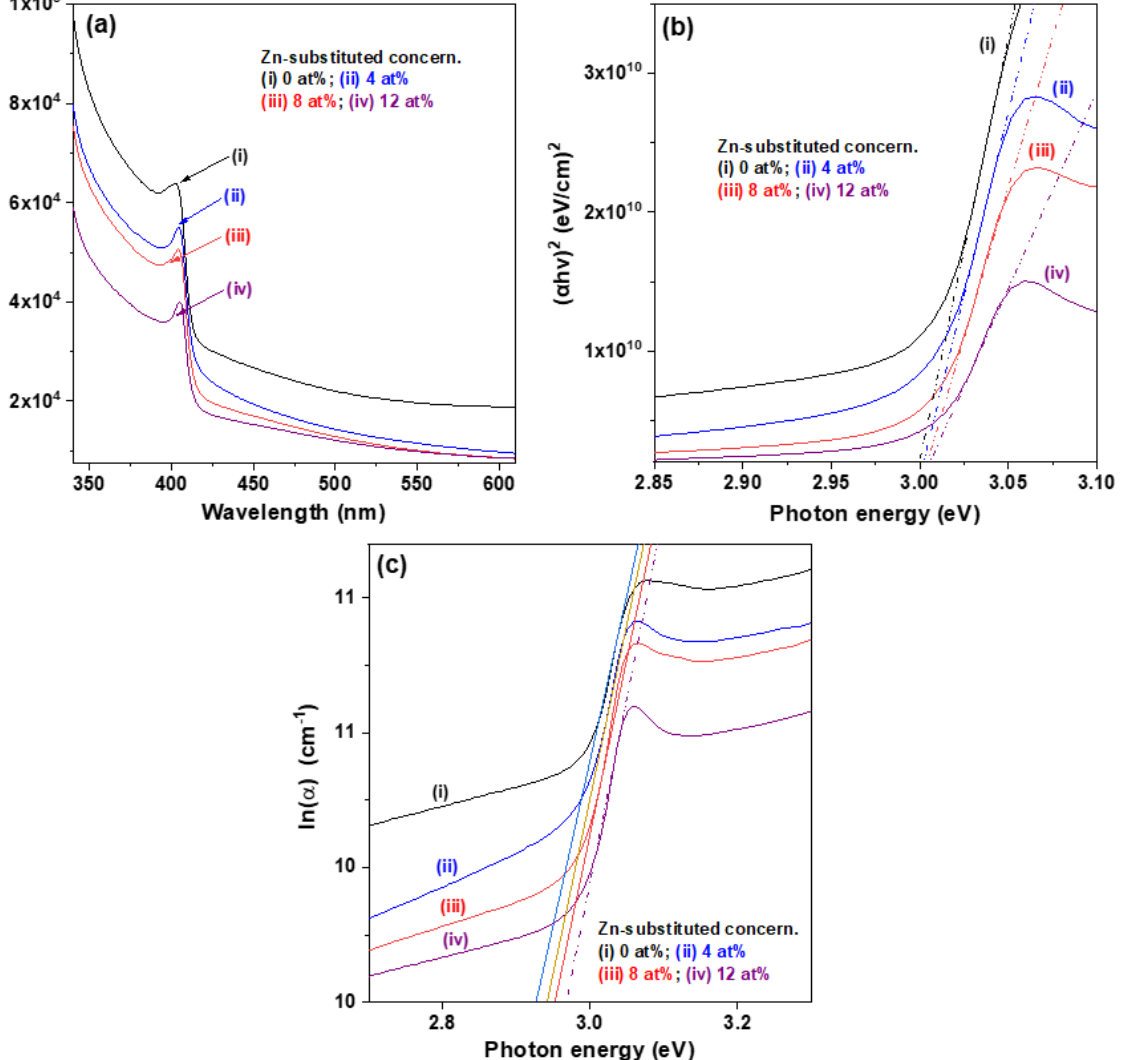
Figure 5. ( a ) UV-visible absorption spectra, ( b ) plot of (αhν) 2 versus photon energy (hν), and ( c ) plot of ln (α) versus photon energy (hν) for the Zn-substituted CuI thin films.